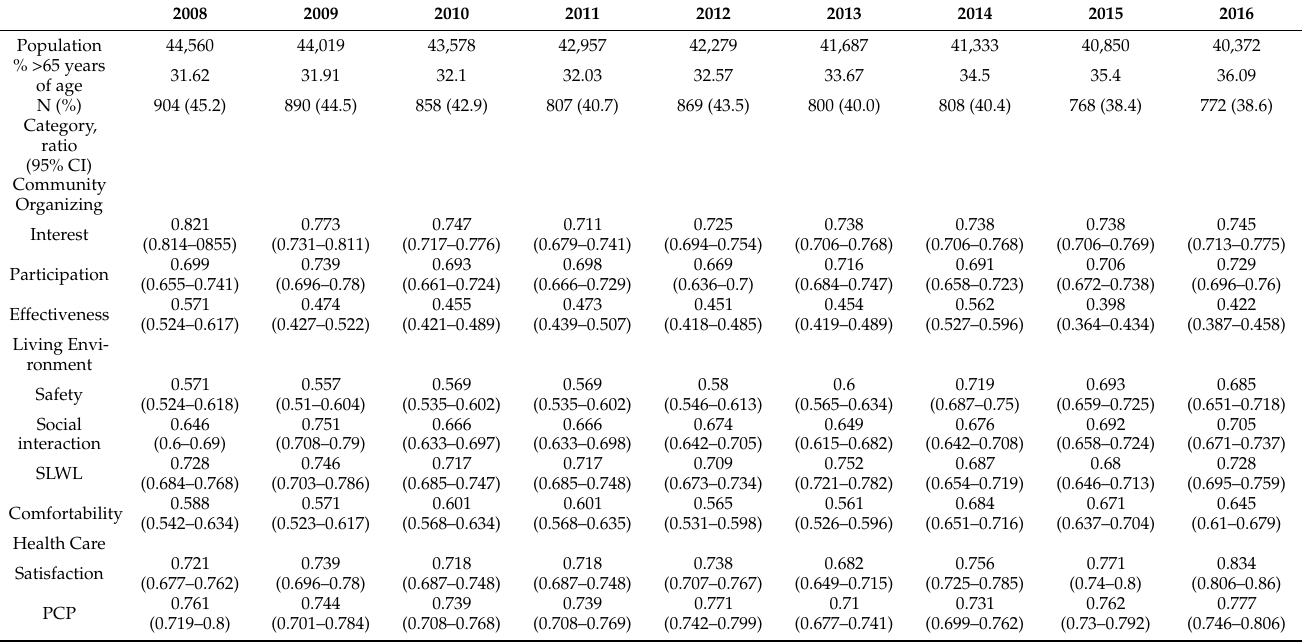
Table 1. Results of the serial cross-sectional questionnaire regarding multifunctional